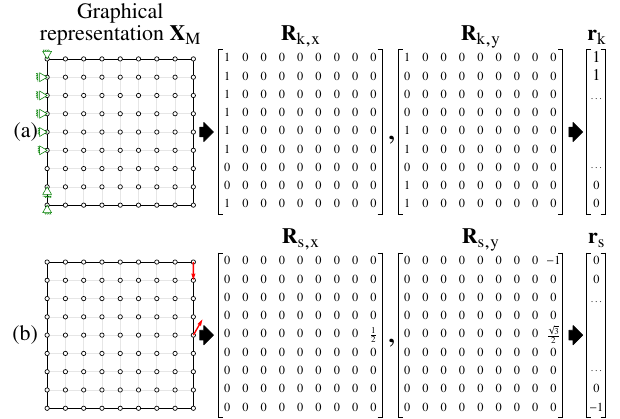
Figure 3. Matrix representation of ( a ) kinematic boundary conditions (structural supports) and ( b ) static boundary conditions (applied